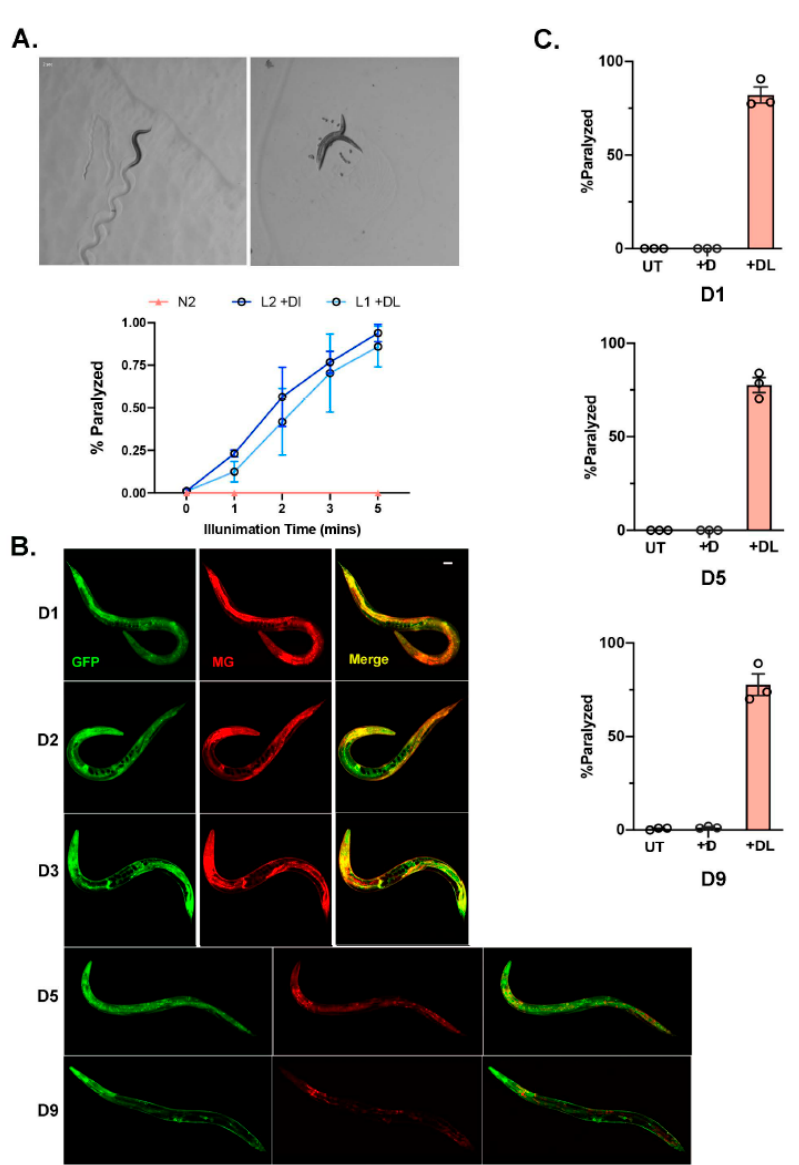
Figure 2. Chemoptogenetic tool can be used to induce oxidative damage in a temporal manner ( A ) N2 with eft-3p::fap::gfp as an extrachromosomal array was soaked in MG-2I overnight and illu- minated with red light. Representative images of N2 integrated lines immediately after red light illumination. A total of 3 independent experiments were performed for each age group. Percent of paralyzed worms is plotted as mean ± SD. ~30 worms were counted for each experiment. ( B ) N2 with eft-3p::fap::gfp integrated lines were soaked with MG-ester as L4 for 24 hr. Colocalization of GFP and MG-ester dye was followed-up in day (D1), D2, D3, D5, and D9 adults. Scale bar = 25 μ m. ( C ) Quantitation of paralysis immediately after red light illumination for 20 min in N2 with integrated eft-3p::fap::gfp . A total of 3 independent experiments were performed for each age group. Paralysis rate is plotted by mean ± SD. A total of 30–60 worms were counted for each experiment.